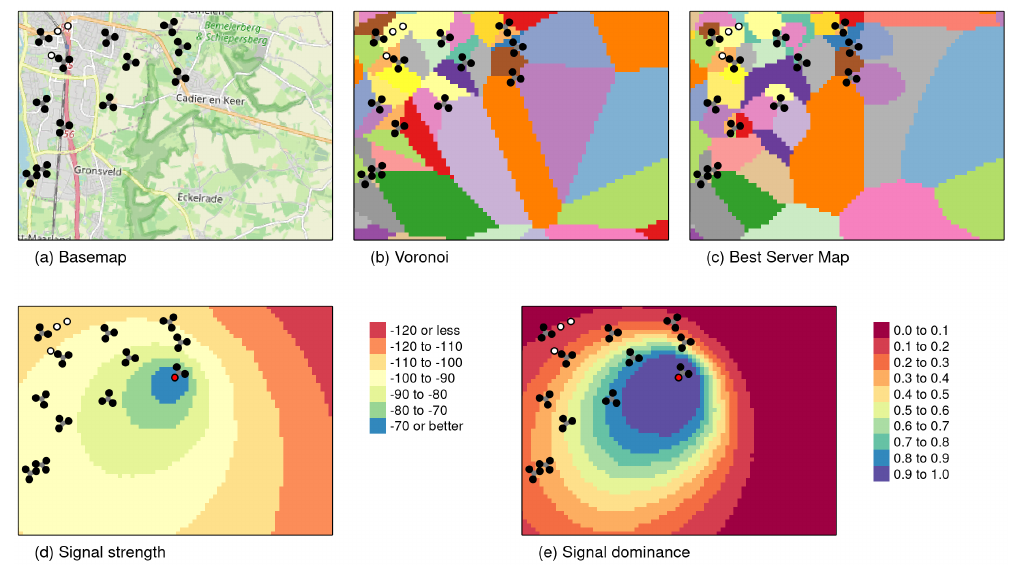
Figure 9: The application of our signal strength